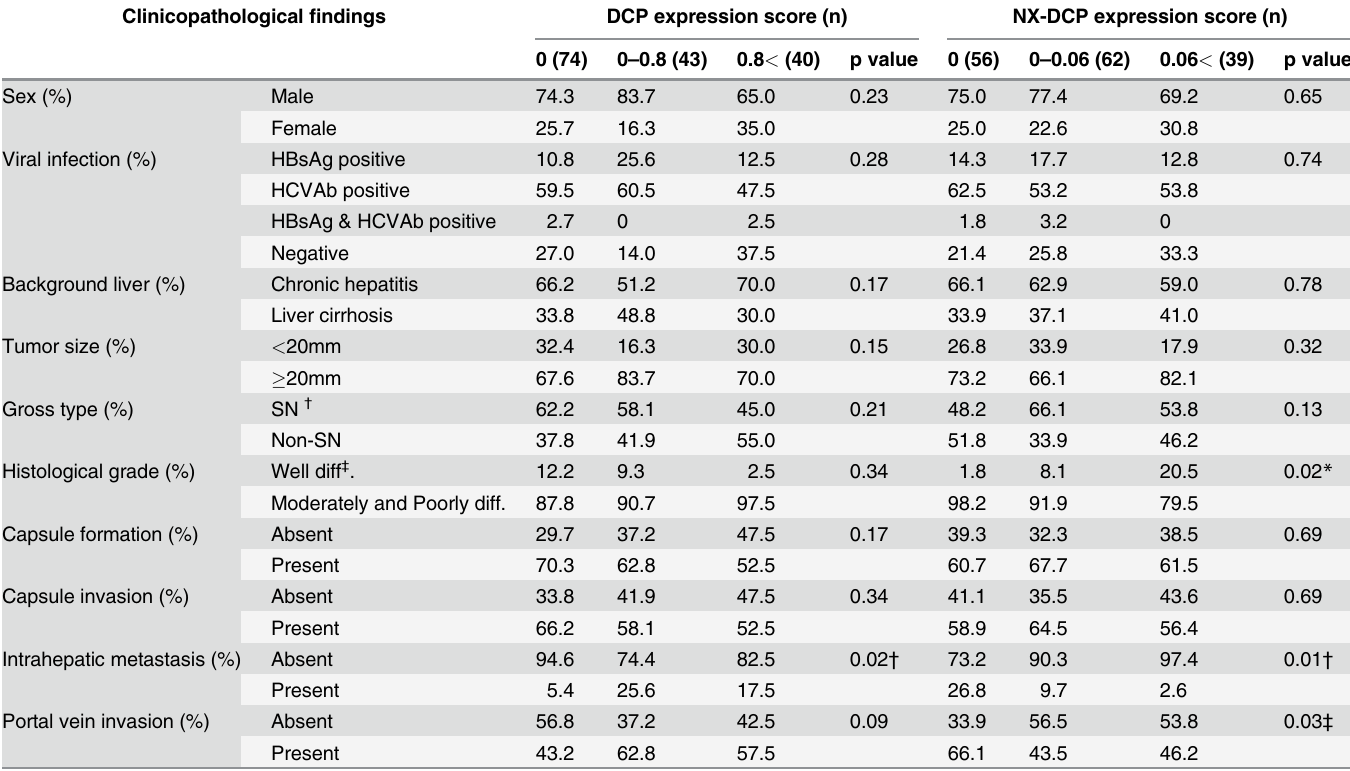
Table 1. Relationship between clinicopathological features and DCP or NX-DCP expression in HCC tissue. Clinicopathological fi ndings